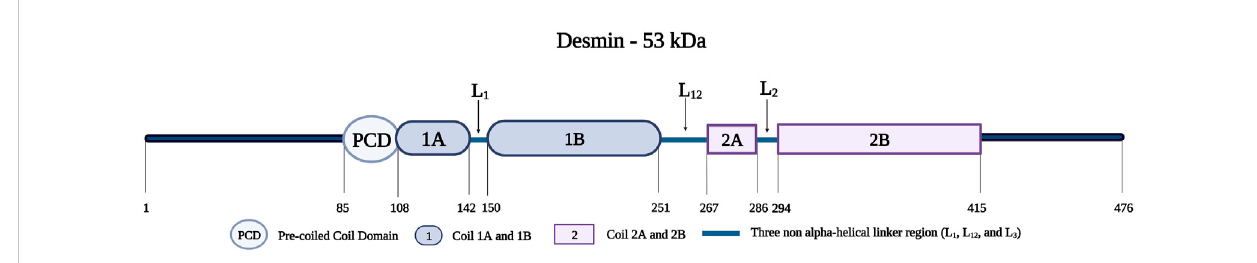
FIGURE 10 Schematicrepresentationofthedesminproteinconsistingofapre-coiledcoildomain,followedbyfourcoileddomains(Coil1A,1B,2A,and2B)that are separated by three linker regions (L1, L12, and L2). Created with BioRender.com. Adapted from (Bär et al.,